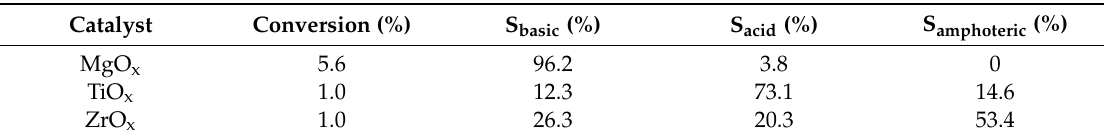
Table 3. MBOH reaction. Comparison between selectivities of the pure oxides. The reaction conditions were as follows: microcatalytic pulse reactor; 20 mg catalyst, 200 °C, methylbutynol (MBOH) pulses of 0.5 µL (see experimental section).